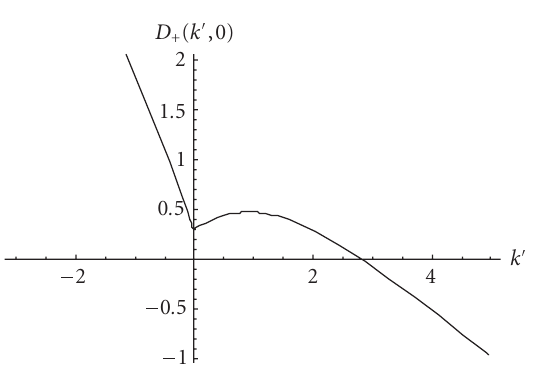
Figure 4.2. Illustrative graph of D + ( k ,0) showing the occurrence of its real zero. ω (cid:6) = 0 . 3 and u (cid:6) 0 = 0 .